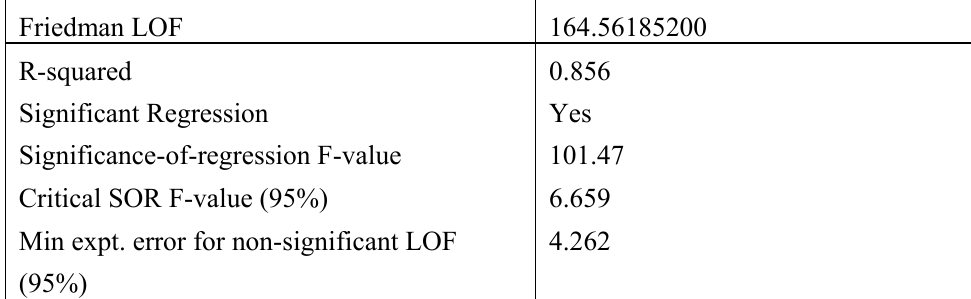
Table 4. Calculation of the typical set of statistical